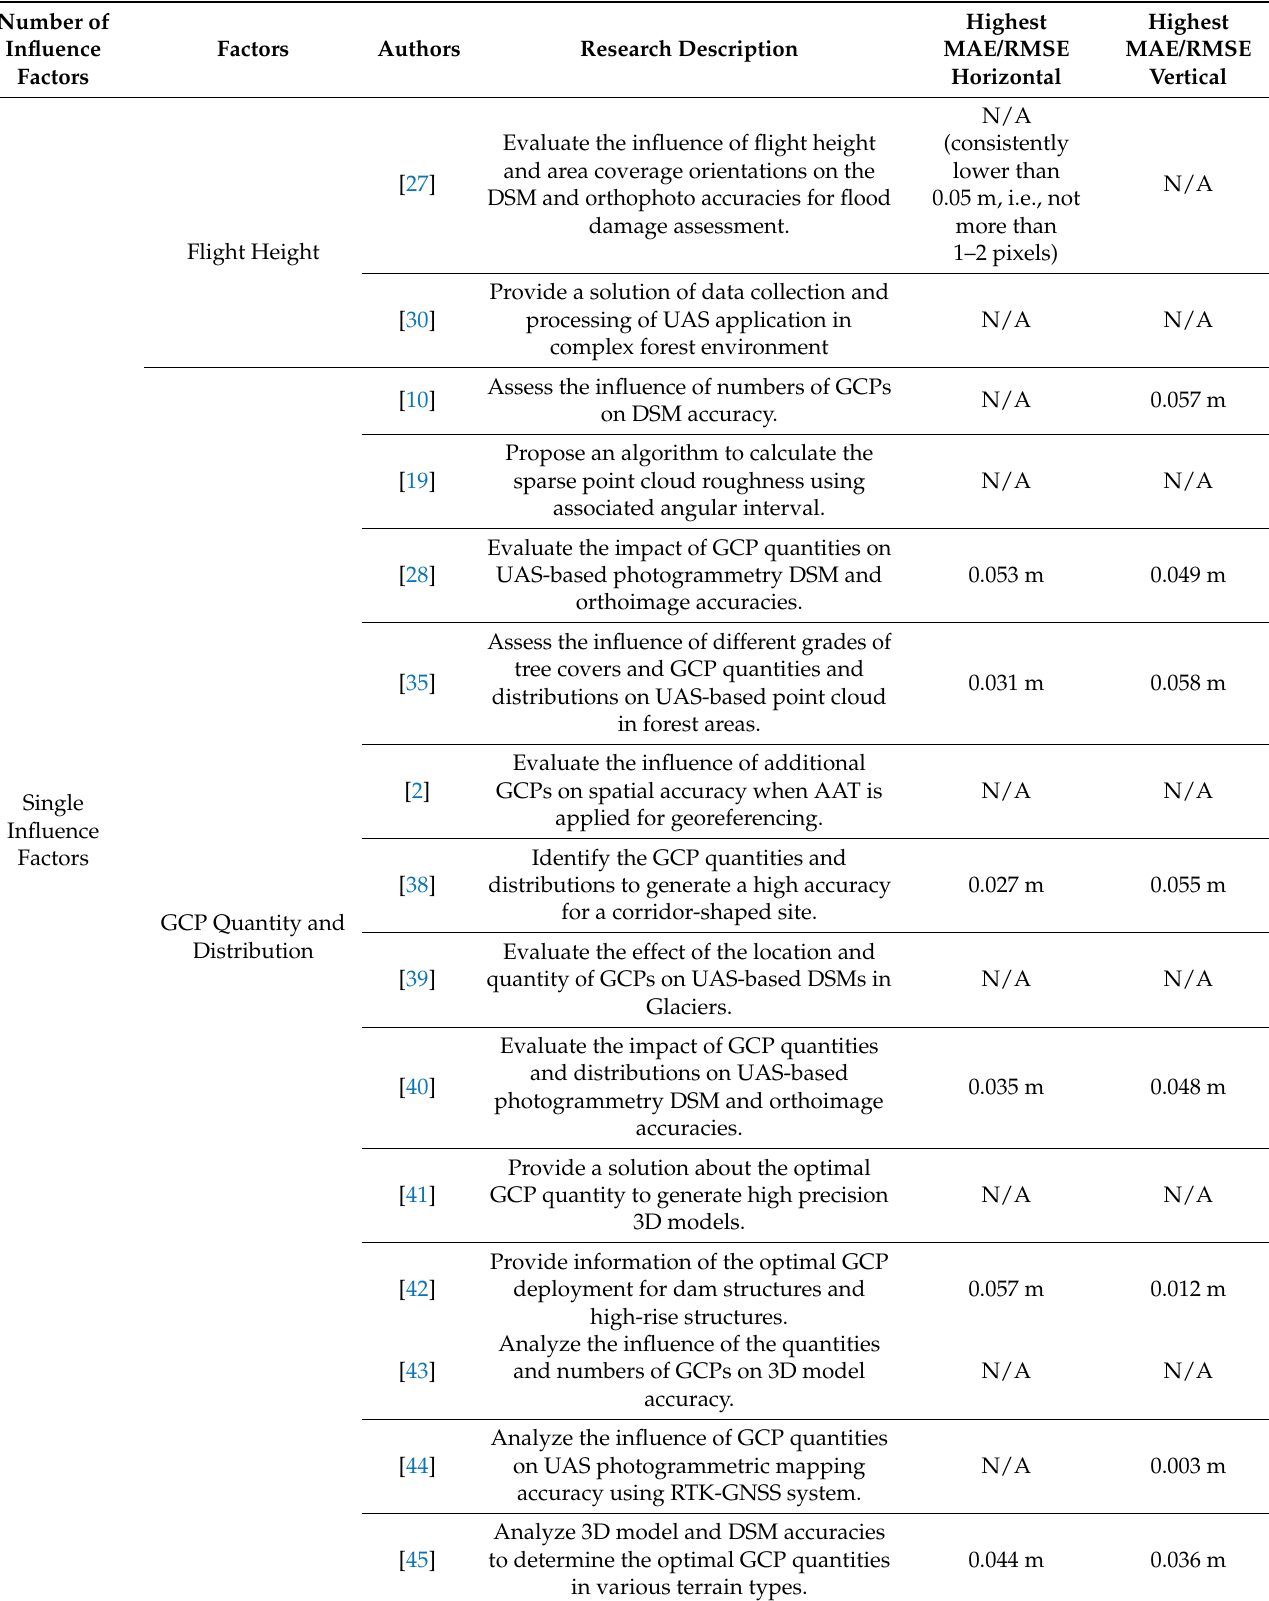
Table 1. Overview of the Related